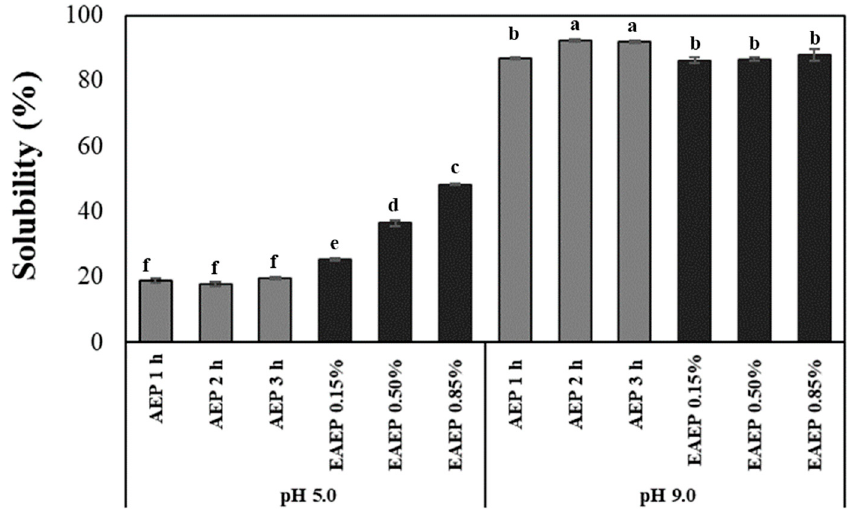
Figure 7. Effects of extraction conditions evaluated during the experimental validation of the AEP and EAEP on the solubility of AEP and EAEP skim proteins at acidic and alkaline pH. Data were analyzed by a two-way ANOVA followed by Tukey’s post-hoc test. Different letters indicate significant difference between samples at p < 0.05.